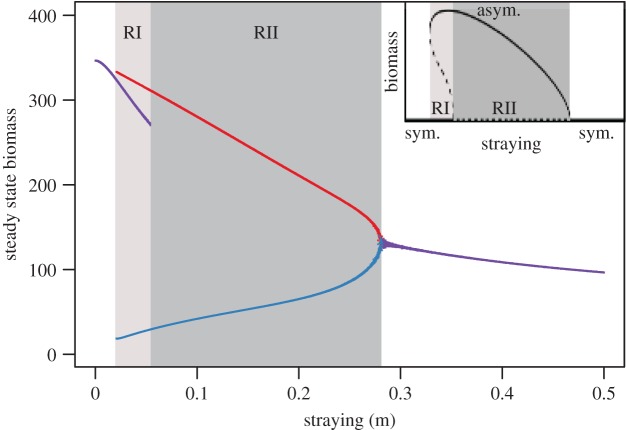
The steady-state densities of Ni and Nj versus straying m for the constant straying model. Alternative stable states exist for regimes I and II, labelled RI and RII, respectively. In regime I, the system can approach qualitatively different states: a symmetric, intermediate state (purple), and asymmetric dominant (red) and subordinate (blue) states. In regime II, only one type of attractor exists: an asymmetric dominant/subordinate state (red and blue points, respectively), and its mirror image where identities of dominant and subordinate are exchanged. Inset: a qualitative sketch of the bifurcation diagram, showing the stable (solid lines) and unstable (dashed lines) fixed points in regimes I (light grey area) and II (dark grey area). The symmetric condition (sym.) is the horizontal line at the base of the inset, whereas the asymmetric condition (asym.) is represented by the curved line. (Online version in colour.)